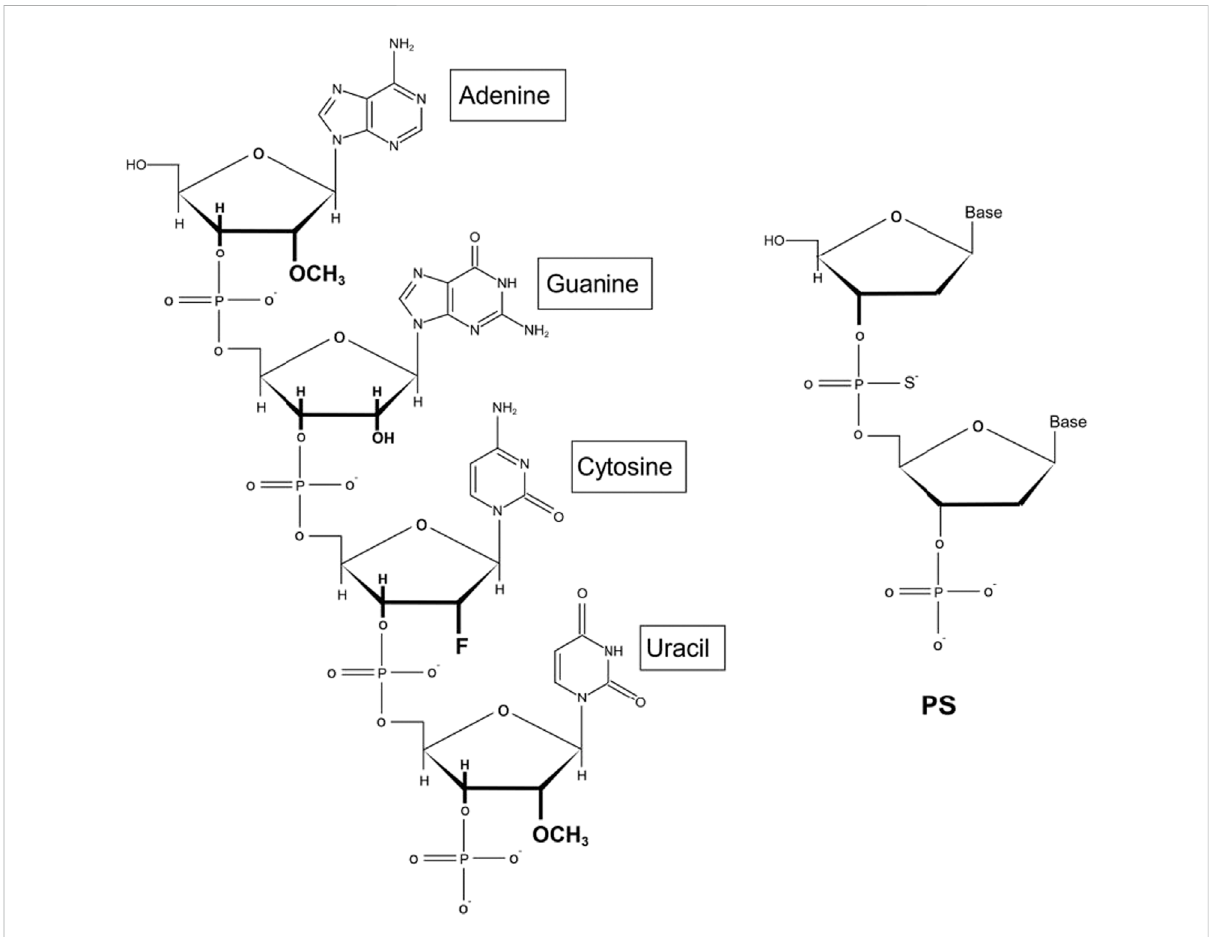
Schemes of siRNA chemical modi fi